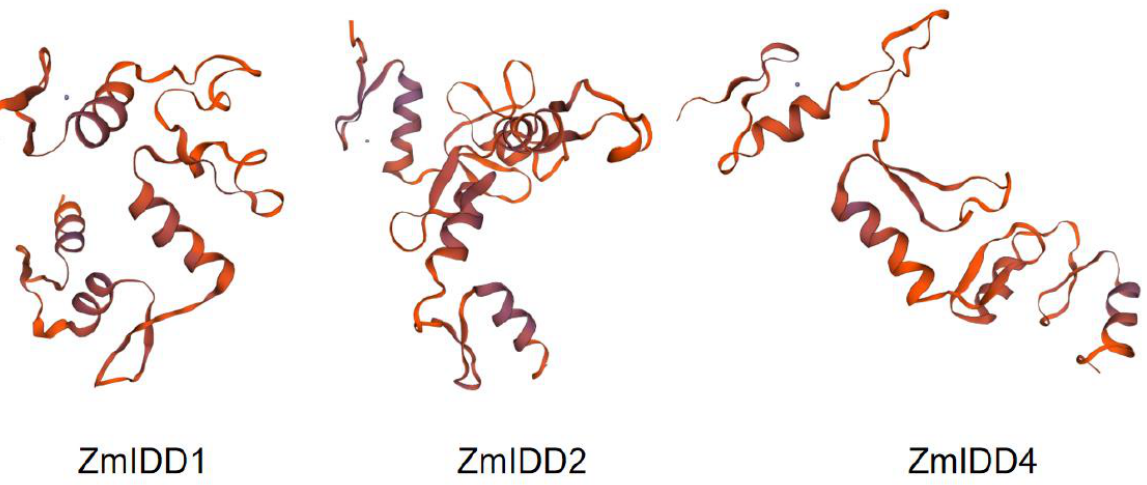
Figure 4. The 3D structure modeling of ZmIDD proteins. The Pymol software was used to create the structural image.